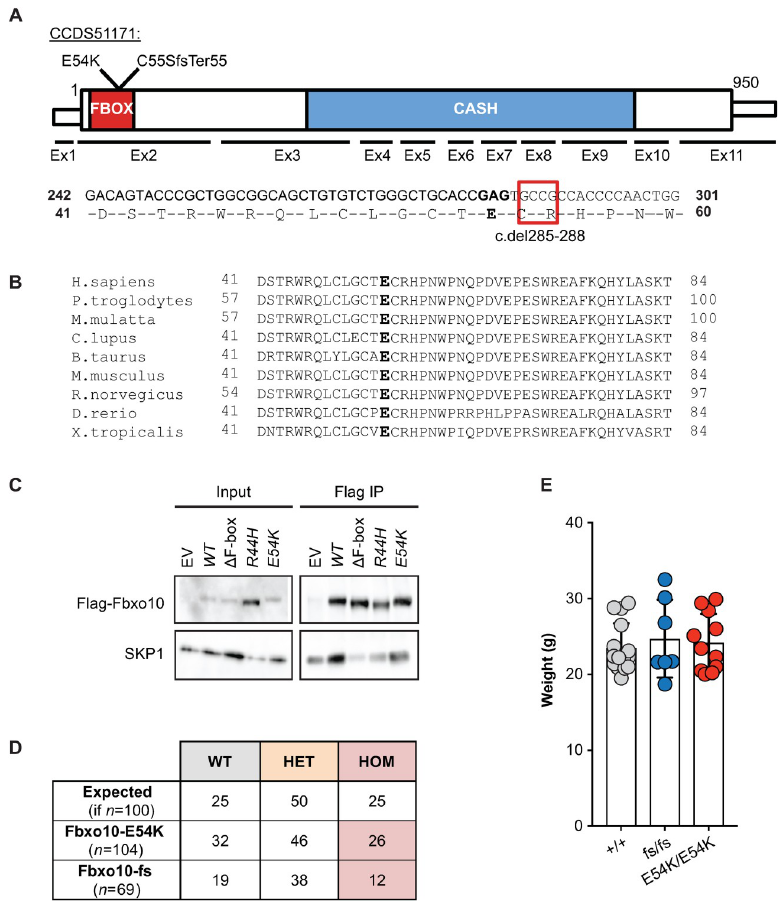
Fig 1. Viable mice with homozygous germline Fbxo10 E54K or Fbxo10 fs mutations. (A) Schematic of mouse Fbxo10 mRNA CCDS51171, showing position of exons, location of mutations, FBOX (SSF81383) and three tandem CASH (SM00722) domains, and the four cDNA nucleotides deleted in the Fbxo10 C55SfsTer55 ( fs ) allele. (B) Alignment of the FBOX10 amino acid sequence from the indicated species: E54 in bold. (C) Expression vectors, either empty (EV) or encoding FLAG-tagged human FBXO10 wildtype (WT) or with the indicated missense mutations or deleting the F- box domain ( Δ F-box) to completely abolish interaction with endogenous SKP1 [26], were transfected into HEK293T cells and lysates or anti-FLAG immunoprecipitates western blotted with antibodies to FLAG or SKP1. (D) Expected and observed numbers of offspring of the indicated genotypes from intercrossed heterozygous parents. Statistical analysis by Chi-Square test with n = 2 degrees of freedom, testing for differences relative to a 1WT:2HET:1HOM expected Mendelian ratio (p = 0.61 and p = 0.55 for Fbxo10 E54K or Fbxo10 fs respectively). (E) Body weight of Fbxo10 +/ + , Fbxo10 fs/fs and Fbxo10 E54K/E54K mice 9–20 weeks old (p = 0.51 and p = 0.62 for Fbxo10 E54K or Fbxo10 fs , respectively). Each dot represents an individual mouse of the indicated genotype. Statistical comparison between each mutant and wild-type group was performed by t-test corrected for multiple comparisons using the Holm-Sidak method. stages of precursor B cell differentiation (Fig 2A and 2B). Congruent with this, there were no detectable differences in expression of B220, CD19, CD93, IgM, IgD, CD21, CD23 or CD86 in these various subsets (S2A Fig). Neither mutation resulted in any changes in distribution of B cell maturation subsets in the spleen (Fig 2C and 2D), nor in any detectable changes in surface expression by splenic B cell subsets of the markers listed above (S2B Fig). Inguinal lymph node and spleen cellularity were also unaffected (Fig 2E). Once more, the lack of a visible effect of Fbxo10 mutation or deletion, even in elderly mice, indicates that FBXO10 plays no role or a functionally redundant role in B cell early development and splenic B cell maturation.